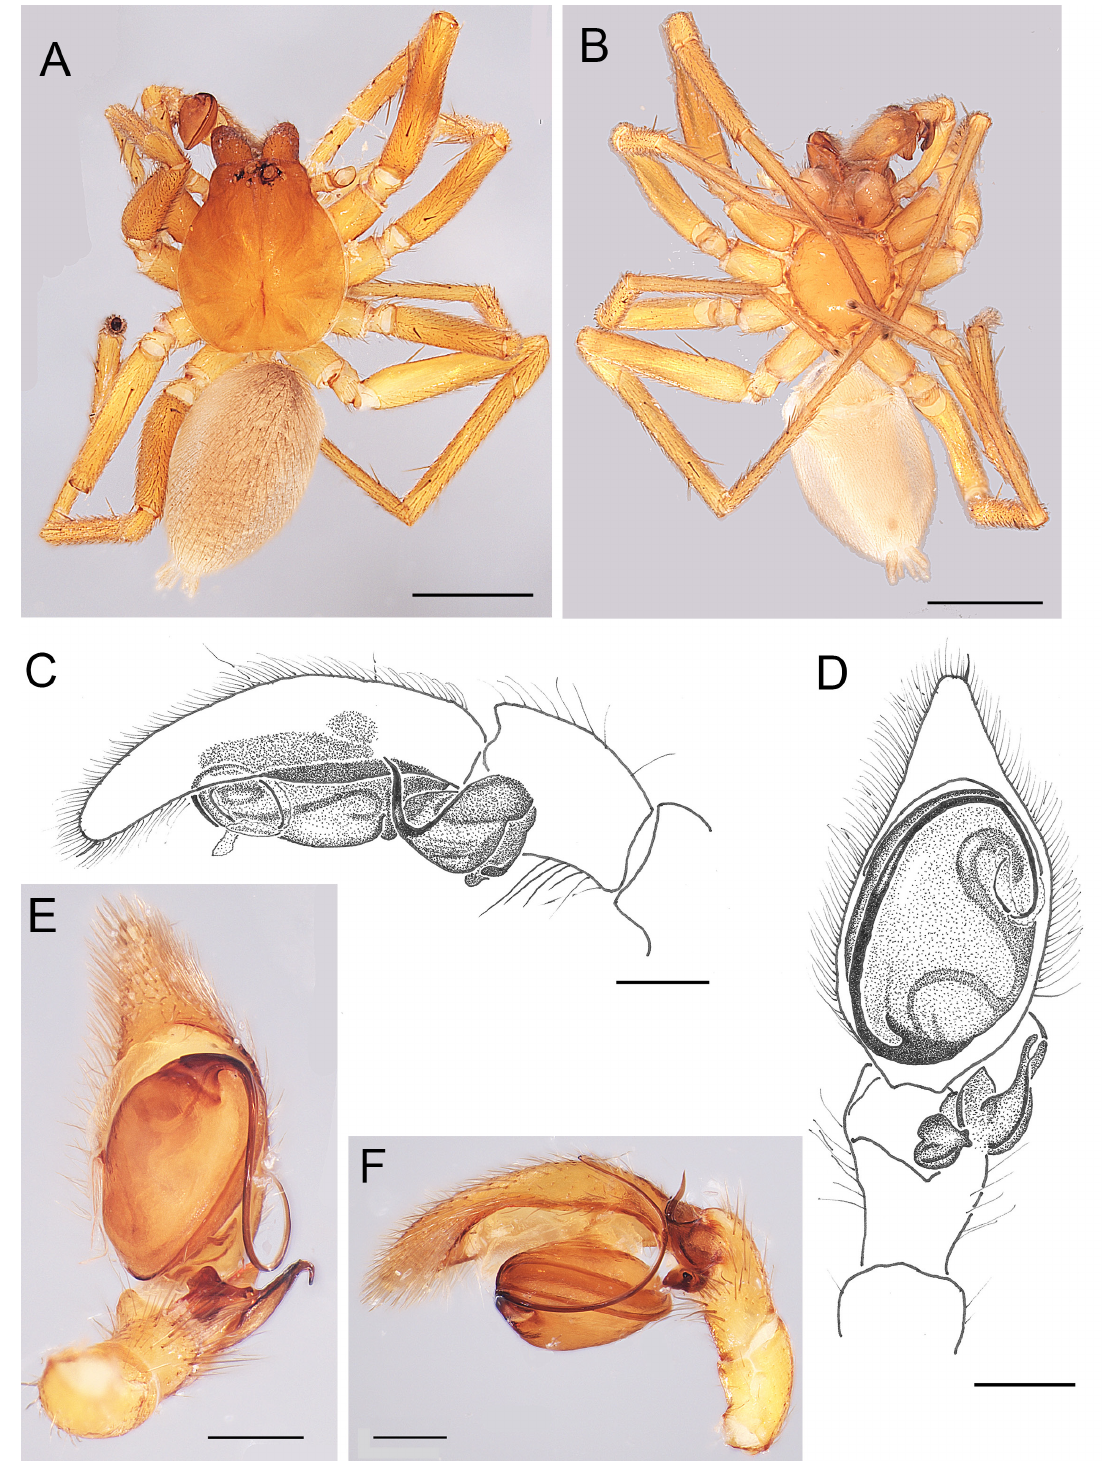
Fig. 19. Andromma dicranobelos sp. nov. A–B, E–F . ♂, paratype ((BE_RMCA_ARA.Ara 222718)). C–D . ♂, holotype (BE_RMCA_ARA.Ara 220165). A . Habitus, dorsal view. B . Same, ventral view. C . Left palp, retrolateral view. D . Same, ventral view. E . Same, expanded (bulb rotated 180°), ventral view. F . Same, retrolateral view. Scale bars: A–B = 1 mm; C–F = 0.2